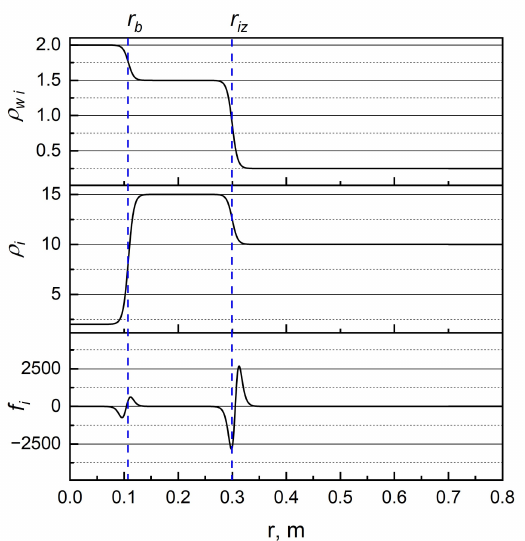
Figure 3. Characteristic view of the functions ρ i and ρ w i , given by Equation (22), and the correspond- ing function f i for the i -th reservoir. The model of the medium includes a well with a radius of 0.108 m and a permeable formation with an invasion zone of radius 0.3 m. The slope parameter of the sigmoid A is taken to be 200, and the value of K da = − 11.6 mV. The dashed lines show the vertical